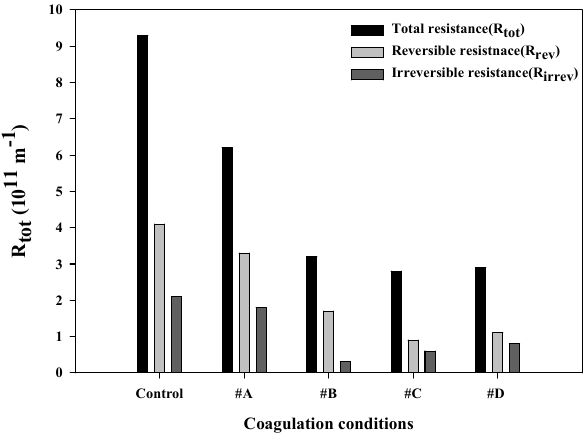
Figure 5. Changes in resistance under each coagulation condition during the in-line coagulation/UF process.